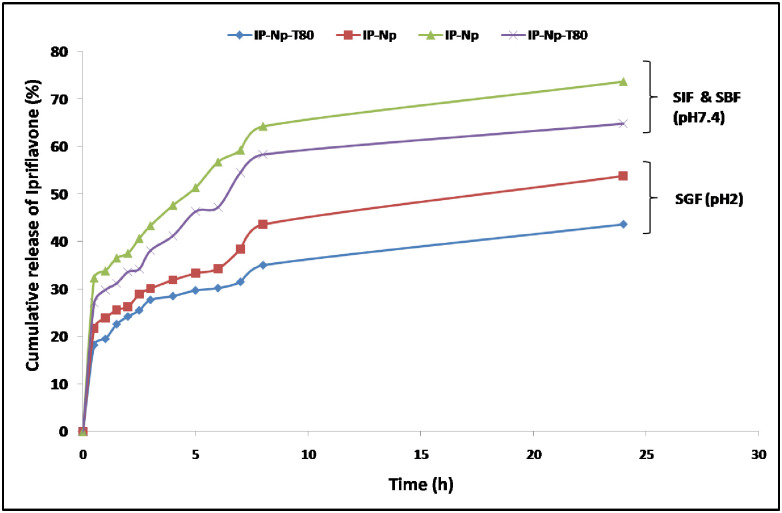
Cumulative release of ipriflavone from nanoparticles (IP-Np) and nanoparticles coated with polysorbate 80 (IP-Np-T80).The drug release was investigated in the dissolution mediums of pH 2.0 (simulated gastric fluid, SGF) and pH 7.4 (simulated blood fluid, SBF and simulated intestinal fluid, SIF).